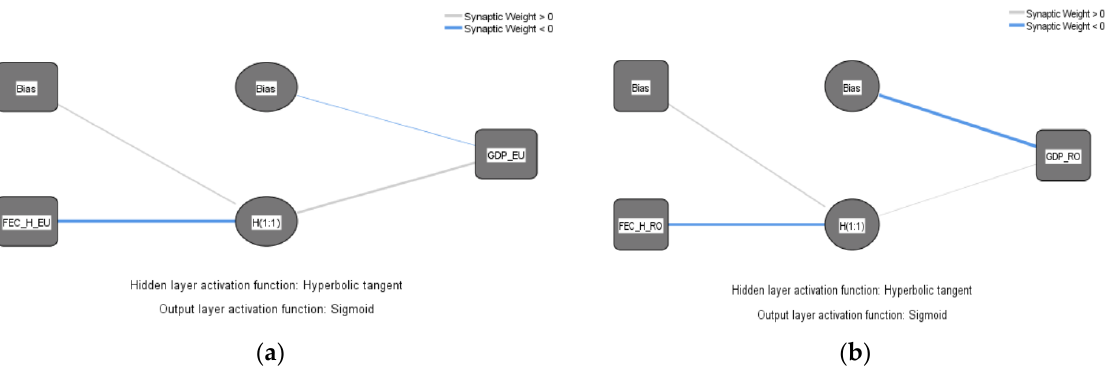
Figure 16. MLP network for identifying the influences of FEC_H on GDP at the EU level and RO levels: ( a ) EU; ( b ) RO.